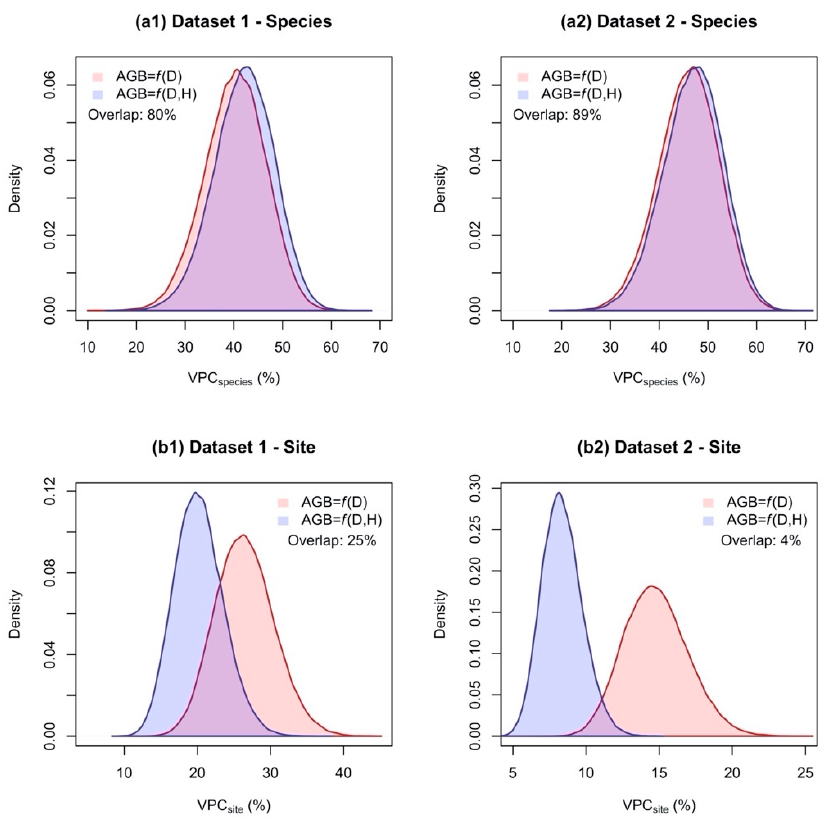
Figure 3. The Variance Partition Coefficient (VPC) density for models based on D only (AGB = f (D)) and for models based on both D and H (AGB = f (D, H)). Note: The density curves are based on VPC values resulted from bootstrap analysis; the ‘overlap’ shows the percentage of the overlapping regions of the two distributions.